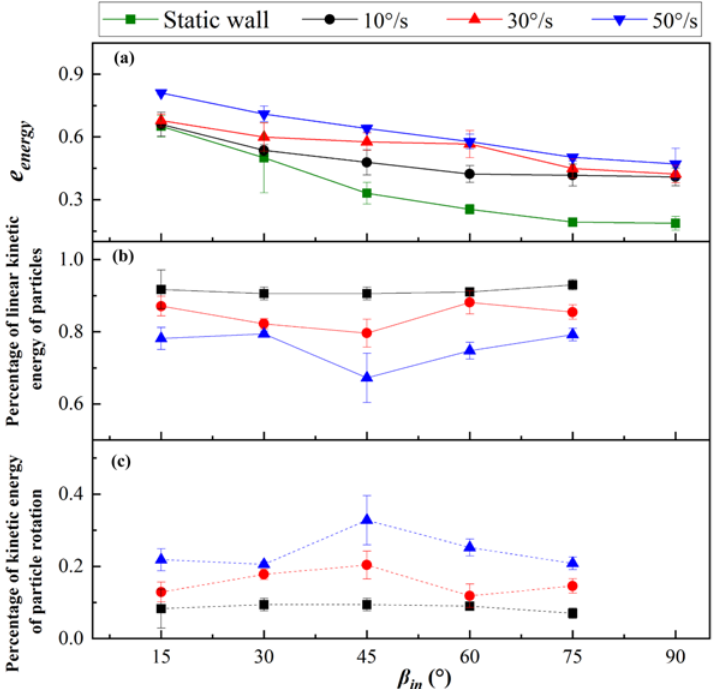
Figure 8. The change in kinetic energy coefficient of restitution at different rotational speeds and the proportion of translational and rotational kinetic energy for particles after collision: ( a ) Kinetic energy coefficient of restitution; ( b ) Percentage of linear kinetic energy; ( c ) Percentage of kinetic energy.